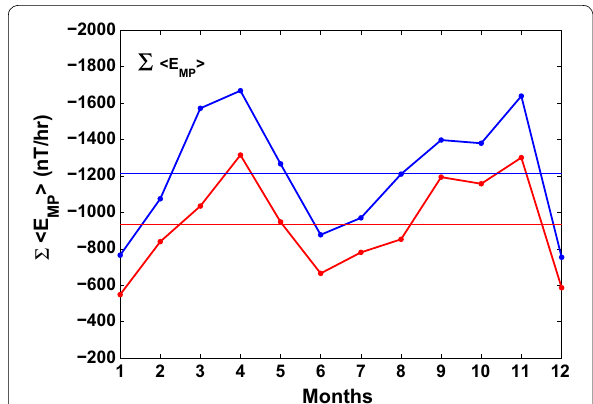
Fig. 8 Seasonal variation of mean energy input during MP of Kyoto Dst ( blue ) and USGS Dst ( red